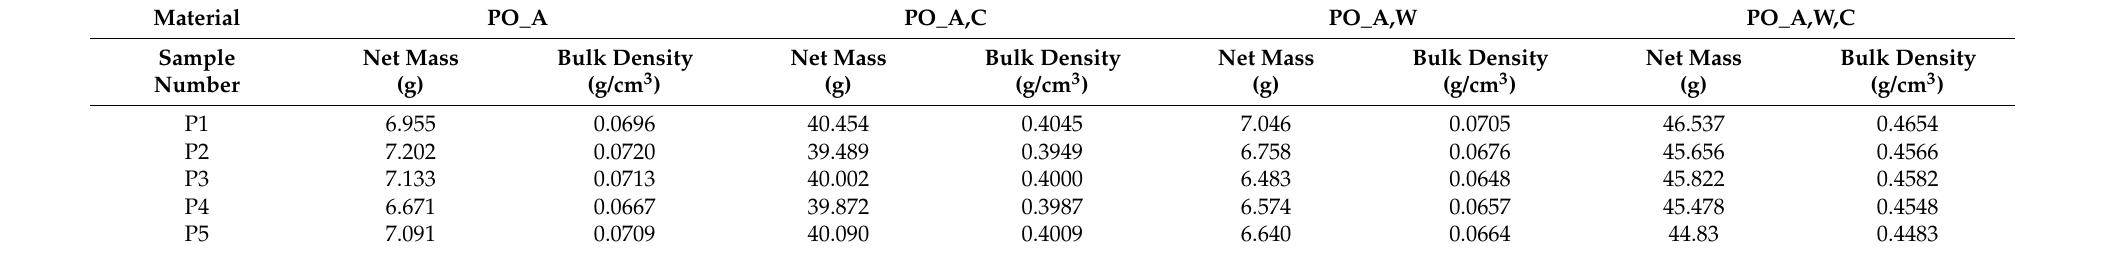
Table A49. Results of bulk density tests of PO_A; PO_A,C; PO_A,W; and PO_A,W,C.